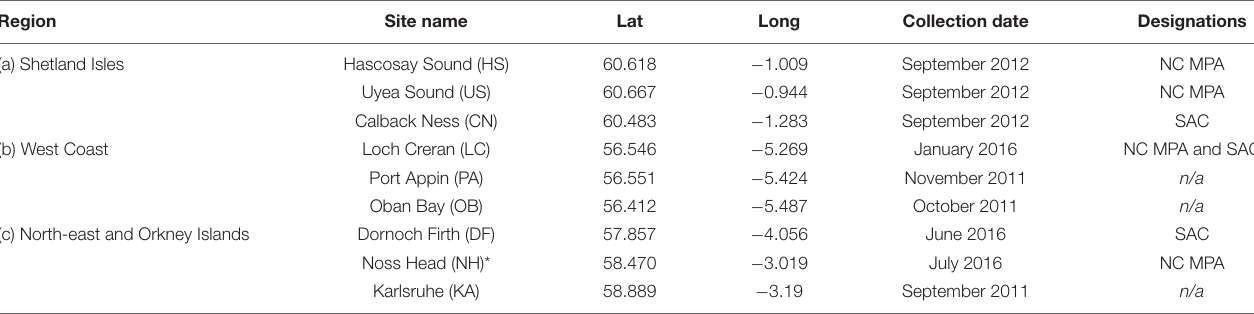
TABLE 1 | Names and locations (latitude and longitude) of Modiolus modiolus reefs included in genetic connectivity analyses for three areas in Scotland: (a) Shetland Isles, (b) West Coast, and (c) North-east and Orkney Islands. Region